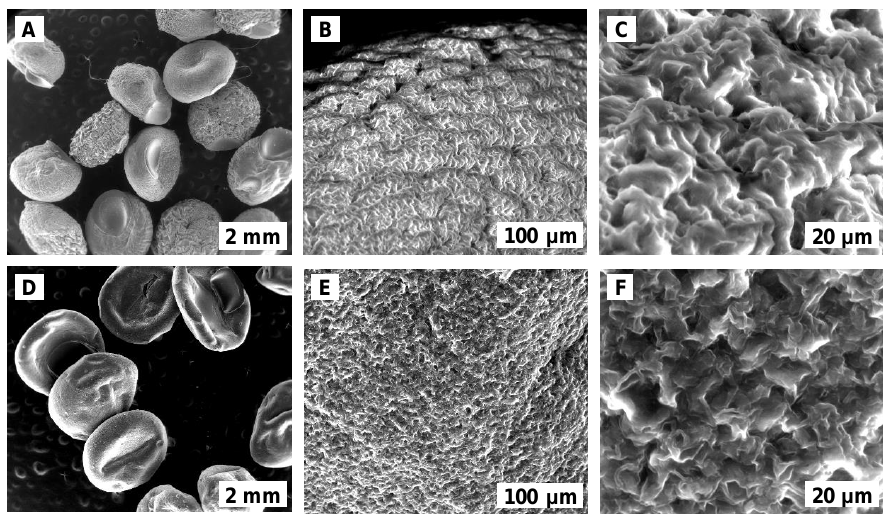
Figure 1. SEM images of SPRBA 5% synthesized biosorbent before ( A – C ) and after biosorption ( D – F ) of ethacridine lactate from aqueous solution.